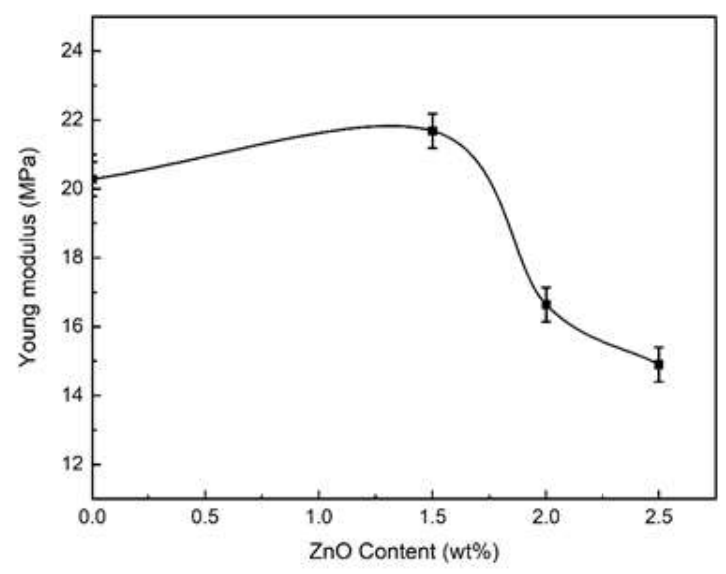
Figure 5: Young modulus of Cellulose acetate and TiO 2 films with different ZnO